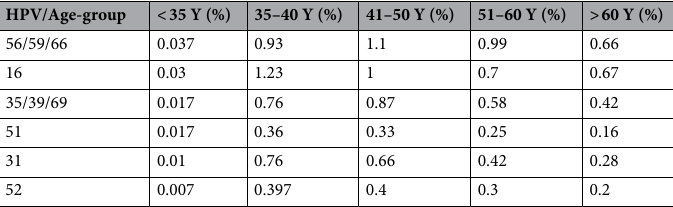
Table 2. The most common HPV-subtypes distributed in the different